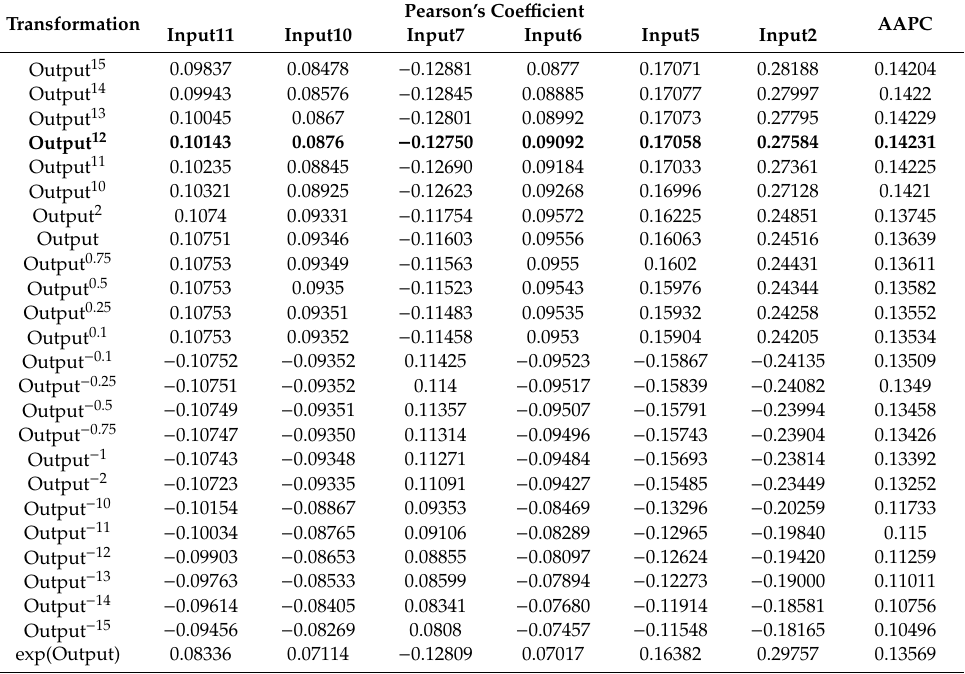
Table 3. Pearson coe ffi cient values calculated for di ff erent transformations between dependent and independent